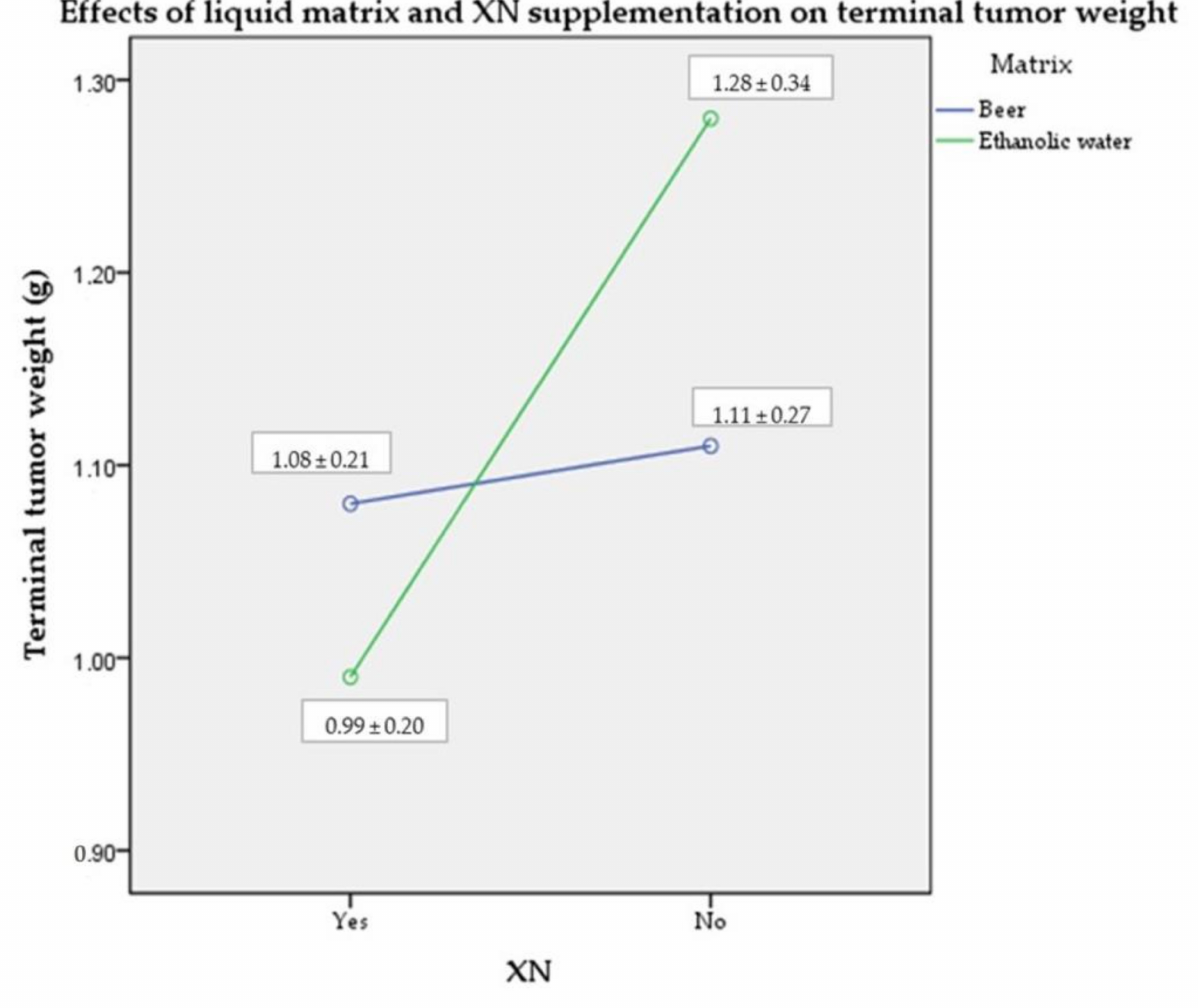
Figure 1. Mean ( ± SD) terminal tumor mass of mice per treatment group ( n = 10). Abbreviations: XN—xanthohumol; SD—standard